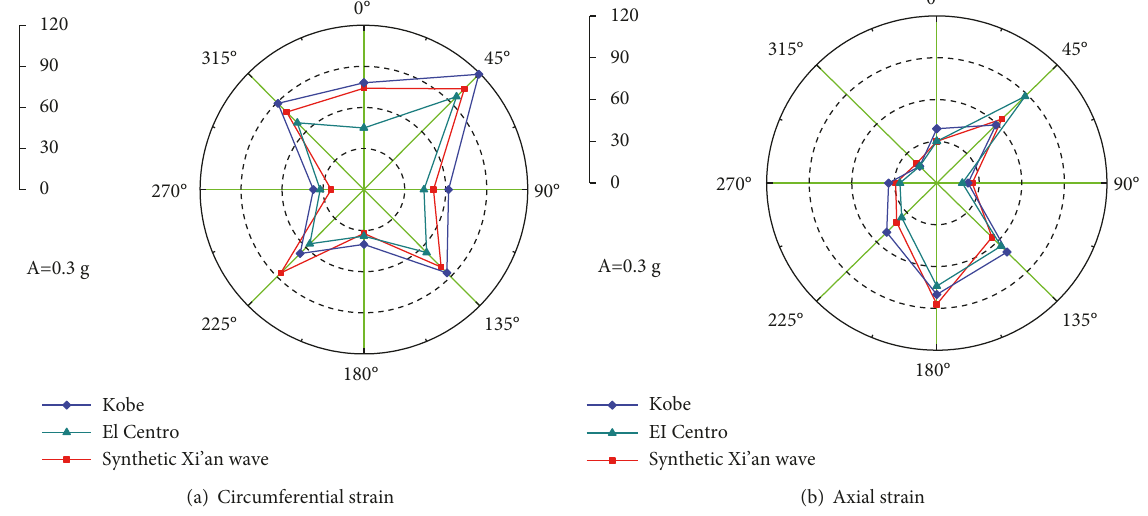
Figure 9: Radar map of dynamic